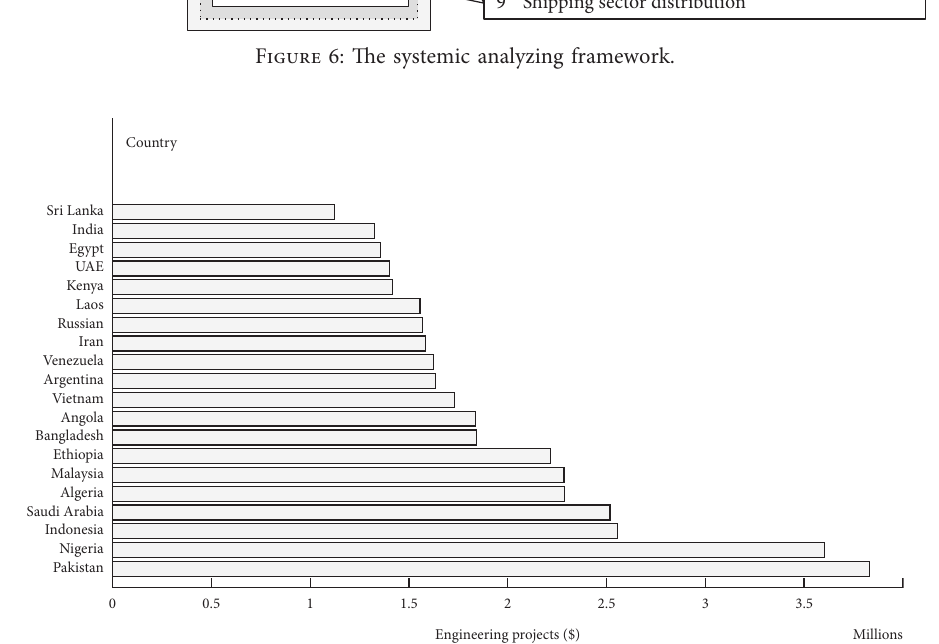
Figure 7: Top 20 IEs with COCP (2005–2017)